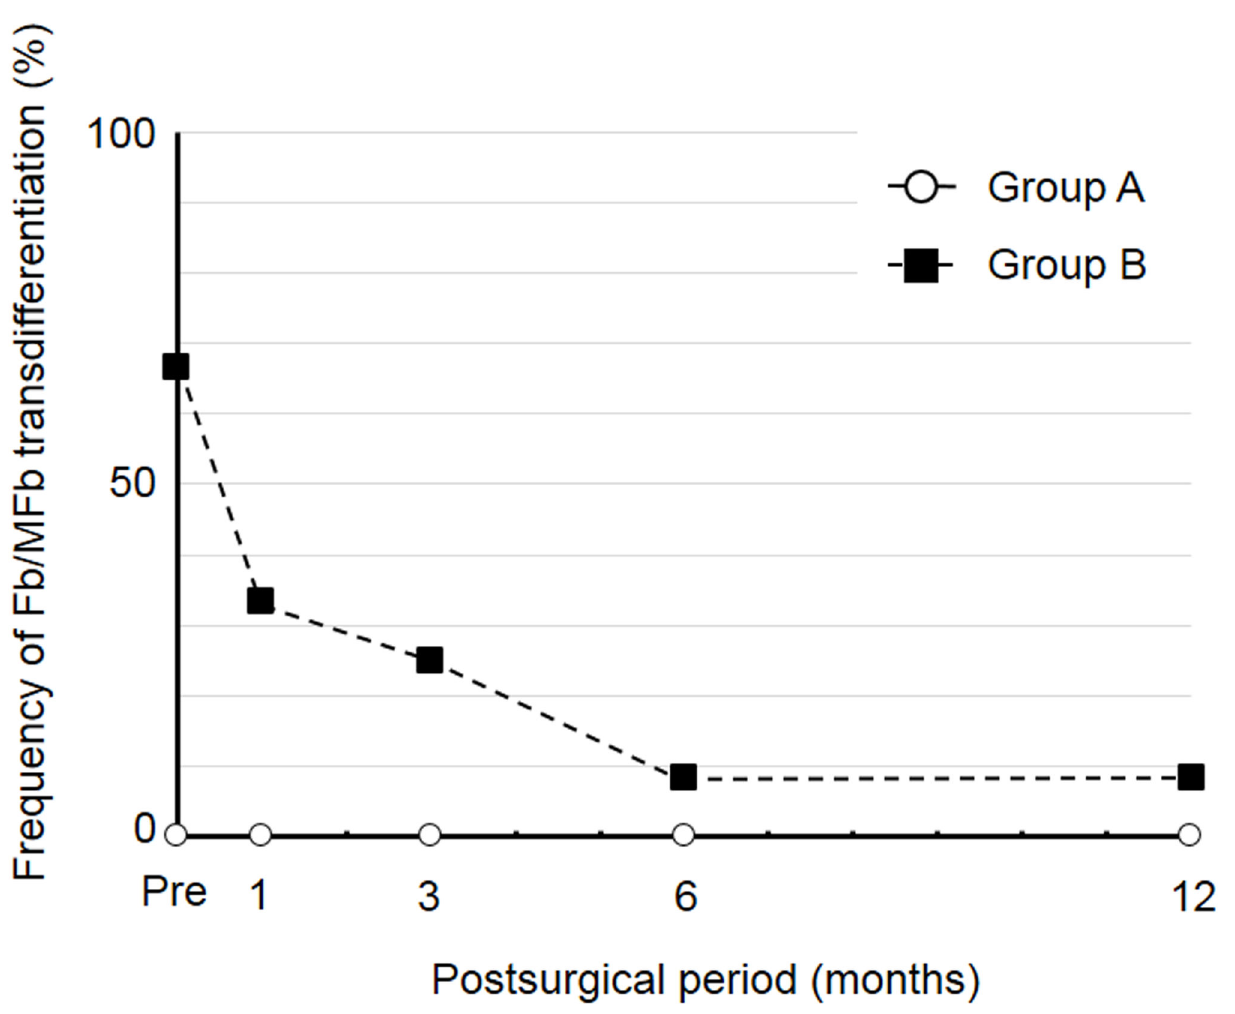
Figure 4. Frequency of Fb/MFb transdifferentiation in groups A and B before and after DSAEK.